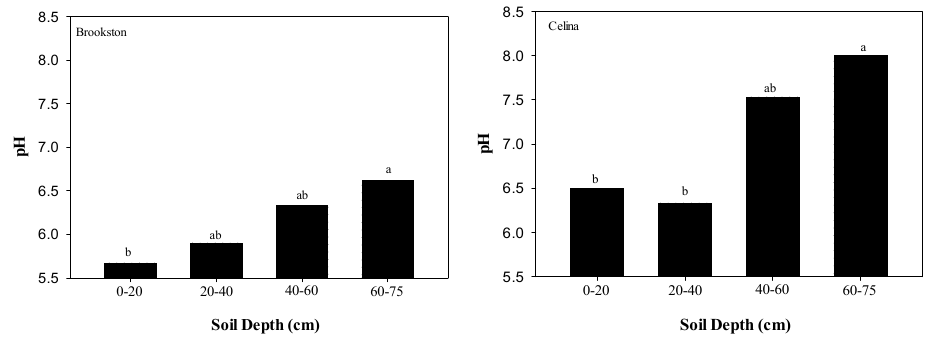
Figure 3. pH values of Brookston and Celina soils in each soil layer. Means followed by the same letter or no letters for each soil and soil layer are not significantly different by Tukey’s test at p < 0.05 .